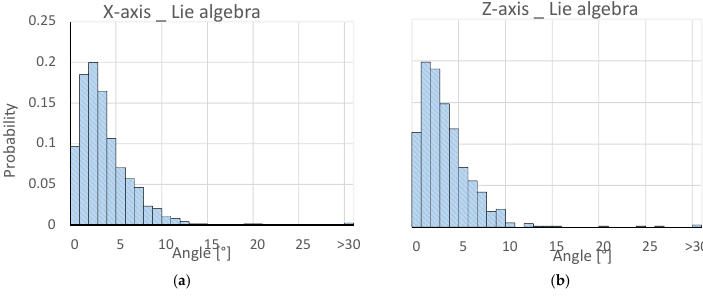
Figure 6. Frequency distributions around the X-axis ( a ) and the Z-axis ( b ).